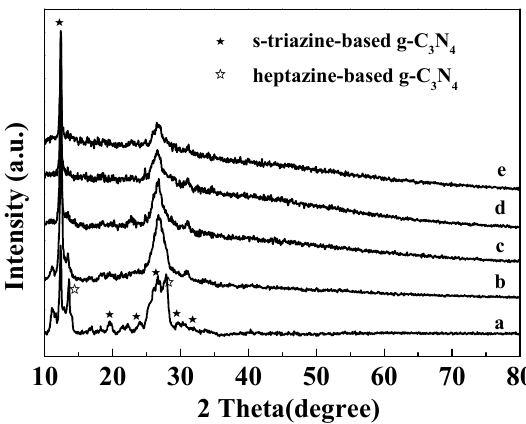
Figure 1. The XRD patterns of ( a ) tri-g-C 3 N 4 , ( b ) 1CoO x /tri-g-C 3 N 4 , ( c ) 3CoO x /tri-g-C 3 N 4 , ( d ) 5CoO x /tri-g-C 3 N 4 , and ( e ) 7CoO x /tri-g-C 3 N 4 .